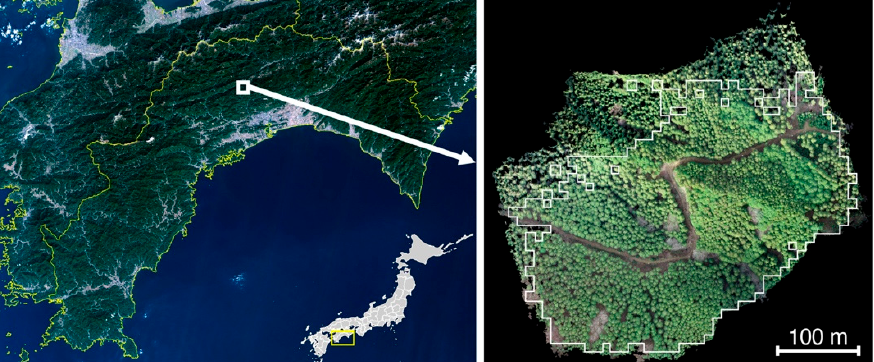
Figure 1. Left image shows the location of the research site (Kochi Prefecture, Japan). The right image is the orthoimage of the site generated by unmanned aerial vehicle/structure-from-motion (UAV/SfM) data. The white frame indicates the area used for the analysis, which corresponds to 10-m-resolution Sentinel-2 multispectral instrument (MSI) data.